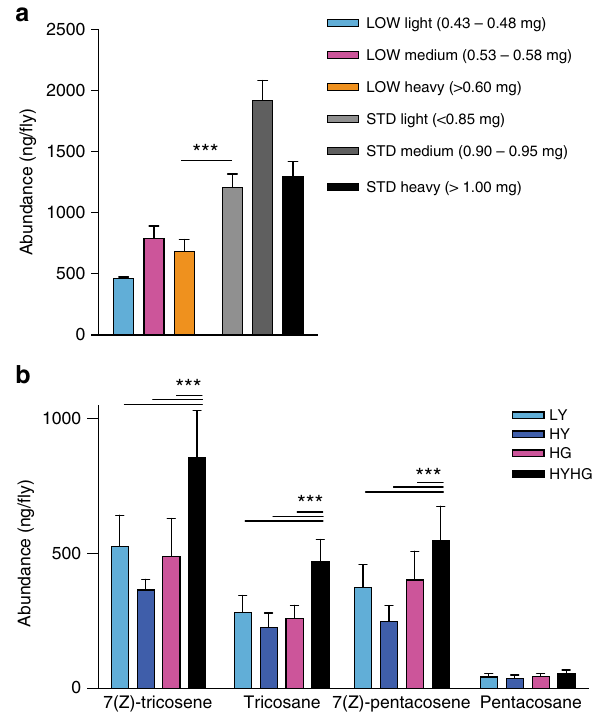
Fig. 8 Autotoxin levels are sensitive to both larval and adult diet. a Larval dietary history regulates cuticular 7(Z)-tricosene levels in white Dahomey males at 3 weeks of age. LOW and STD fl ies were sorted into three weight bins, revealing that LOW heavy fl ies have signi fi cantly less 7(Z)-tricosene than STD light fl ies, despite being close in body size ( n = 3 for LOW light and LOW medium, n = 5 for LOW heavy, n = 6 for STD light and STD medium, and n = 4 for STD heavy). b Adult diet in fl uences cuticular 7(Z)-tricosene levels in STD iso31 males at 3 weeks of age. The levels of the four major male cuticular hydrocarbons are higher on HYHG than on LY, HY or HG adult diets ( n = 6). *** p < 0.001, two-way ANOVA followed by the Bonferroni multiple comparisons test. Error bars show 1